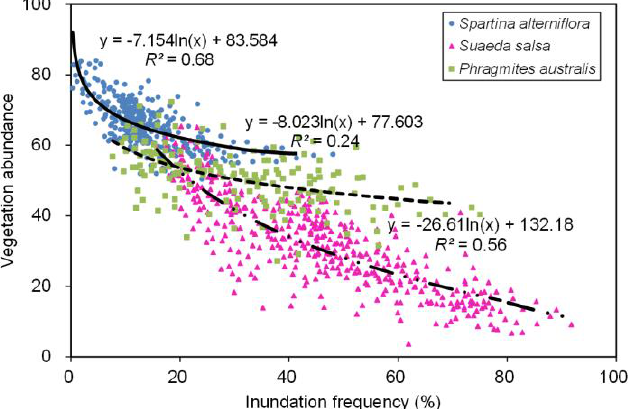
Figure 10. The relationship between inundation frequency and vegetation abundance of samples in three types of wetland vegetation.